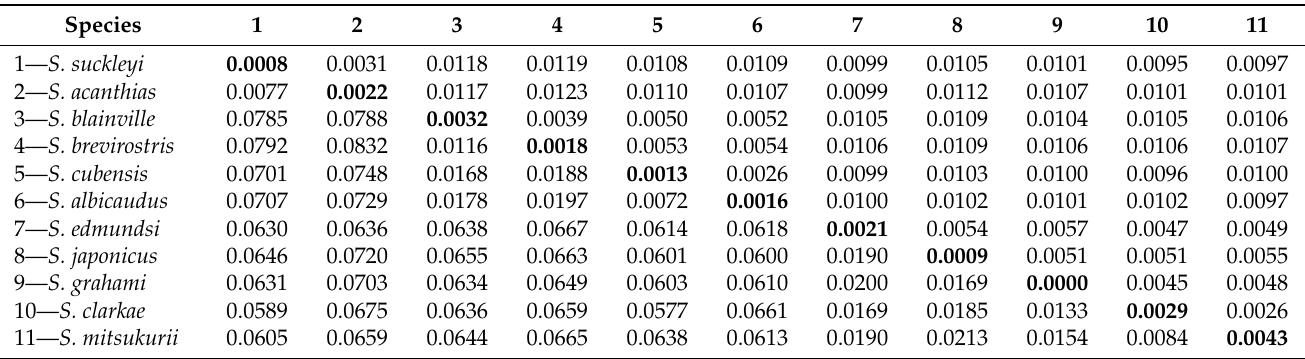
Table 1. Genetic distances (K2P) based on COI sequences among Squalus species (below the diagonal) and standard errors (above the diagonal). The numbers in bold represent the intraspecific K2P genetic